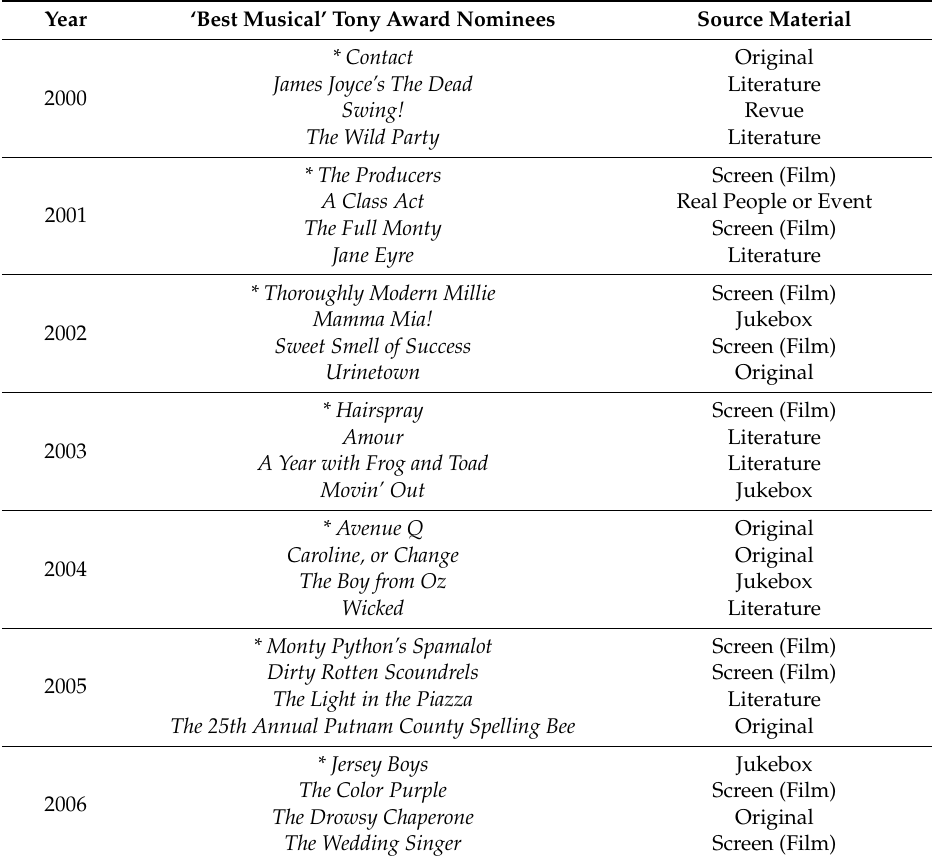
Table 1. Source materials of ‘Best Musical’ Tony Award winners and nominees (2000–2019). ‘Best Musical’ Tony Award